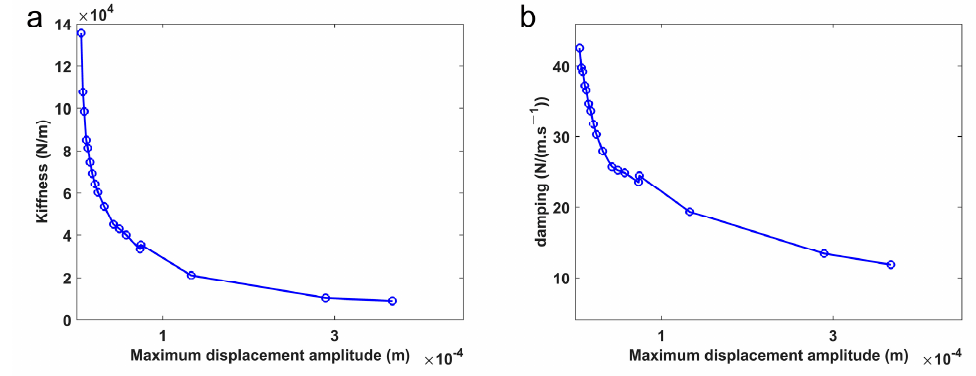
Figure 7. Evolution of the stiffness ( a ) and the damping ( b ) with respect to the amplitude of displacement. FRF based on different excitations under random vibration.